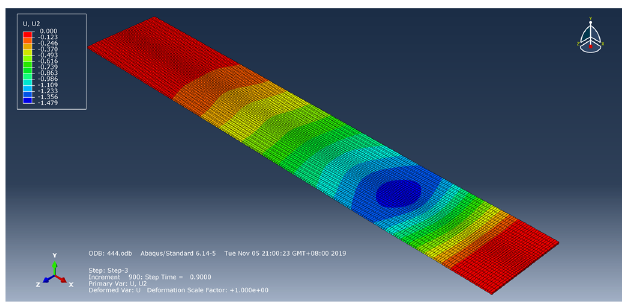
Figure 8. Vertical vibration displacement map diagram at 0.9 s.